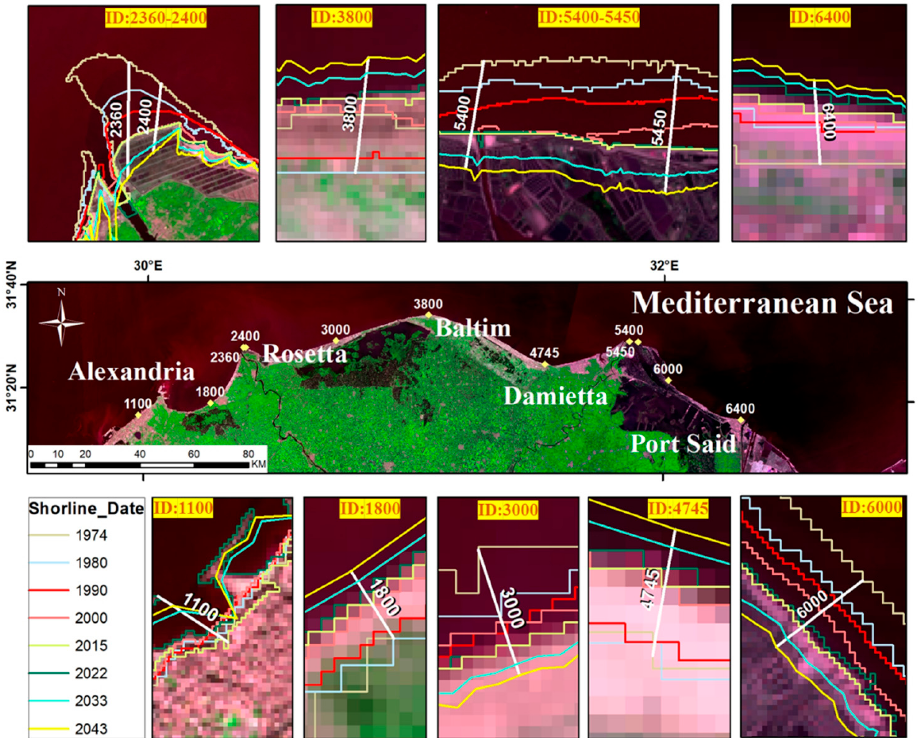
Figure 7. The projected shoreline at different transects in the Nile Delta for the period 1974–2043. Transects at Alexandria, Idku, Lake Burullus, Baltim, Gamasa, and Port Said show